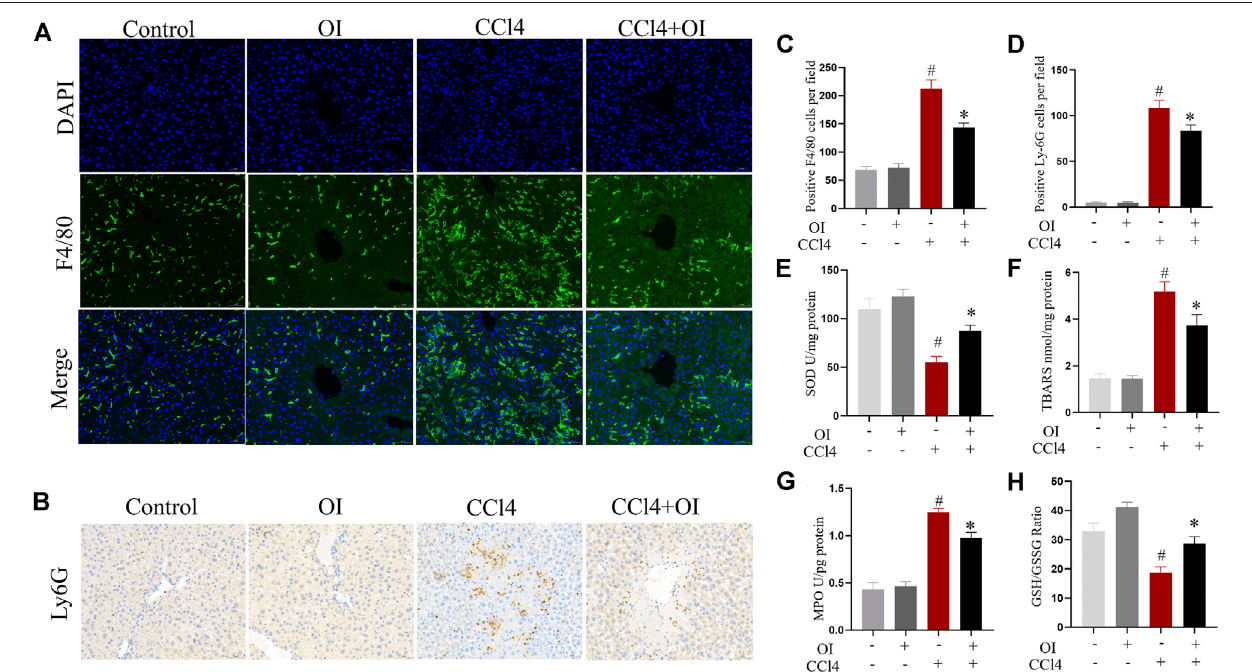
FIGURE 2 | Effect of OI on the in fi ltration of innate immune cells and oxidative stress in mice. (A) Immuno fl uorescence detection of F4/80-positive cells in hepatic sections from each group; DAPIwasused toshownucleus. (B) Immunohistochemicaldetection ofLy6G-positive cellsinliver sections ofeach group. (C) Positive F4/80 cells per fi eldwereanalyzedfor fi ve visual fi eldsperliversectionsfrom each group. (D) Positive Ly6G cellsper fi eldwereanalyzedin fi vevisual fi eldsperliversectionfrom each group. (E) The activities of SOD were measured in each group. (F) TBARS levels were measured in each group. (G) Activities of MPO were evaluated in each group. (H) The GSH/GSSG ratio was measured in each group. Original magni fi cation, × 200. Data are expressed as mean ± SEM ( n (cid:1) 5 for each group); # p < 0.05 vs. control group; * p < 0.05 vs. CCl4-treated